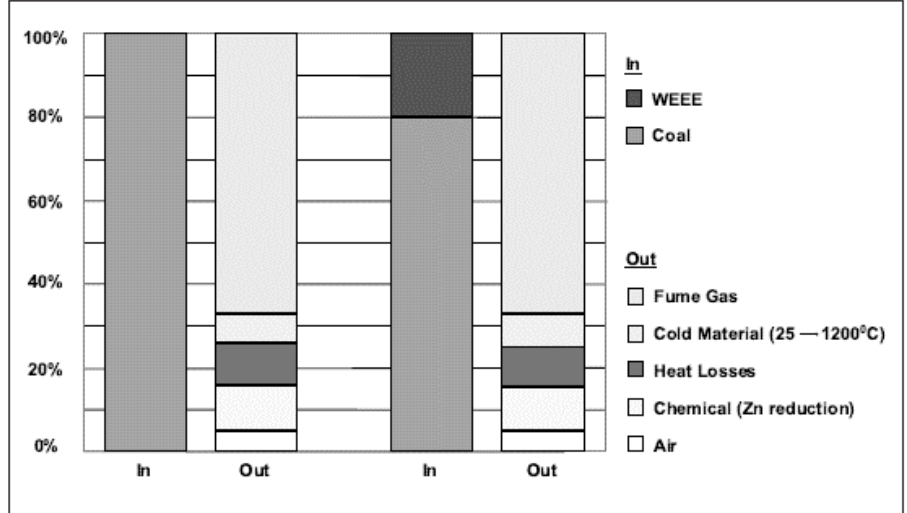
Figure 16. Influence of plastics on the energy balance in the furnace [96].